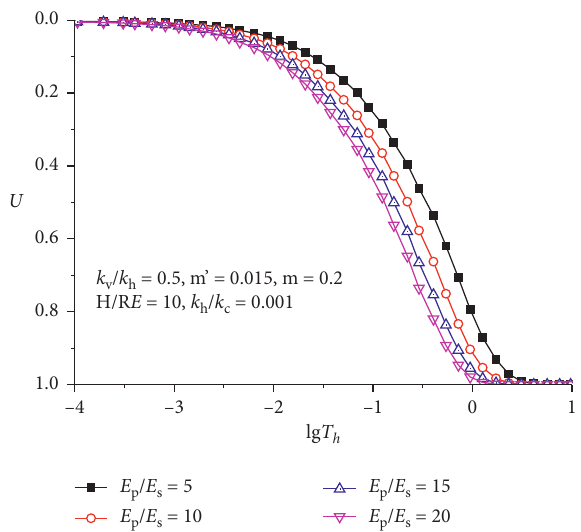
Figure 5: Influence of displacement ratio of cement soil pile on foundation consolidation rate.